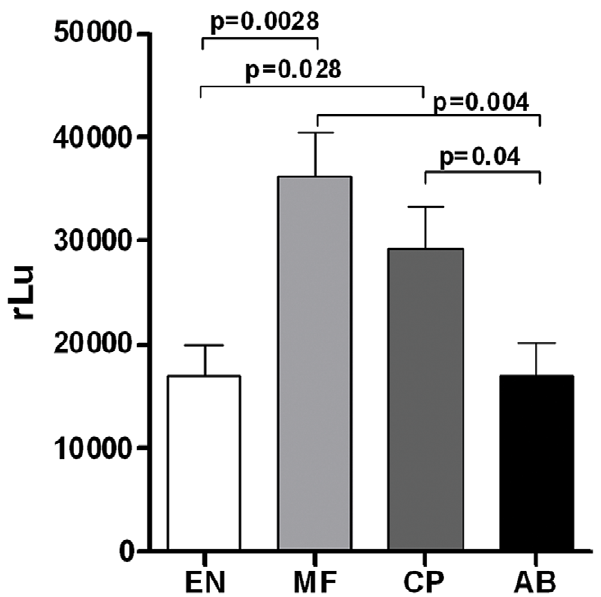
Figure 2. Filarial serum/plasma induced proliferation. LEC cultured with 1% pooled plasma from different patient groups (EN, MF, CP, AB) and proliferation measured by uptake of BrDU at 96 h. Data are expressed as relative luminescence units (rLu) over media controls and are expressed as the mean ( + 95% CI).